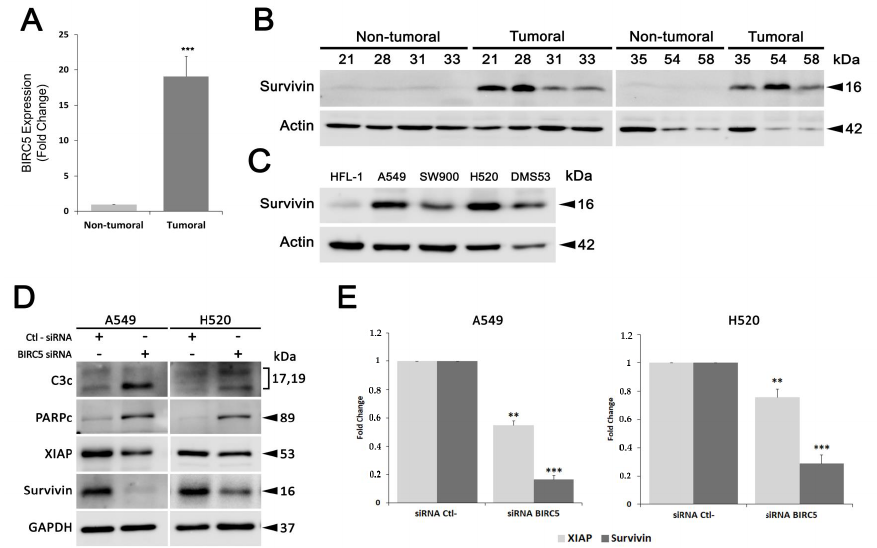
Figure 1. Survivin expression levels in lung cancer tumor samples and survivin functional validation in cellular models. ( A ) qPCR validation of BIRC5 expression levels. Fold changes of gene expression were calculated using β -actin as the housekeeping gene. ( B , C ), survivin levels were analyzed using whole cell lysates from patient tissue samples and lung cell lines by Western blot analysis. ( D , E ), After 48 h of transfection with siRNA against survivin mRNA, the expression of survivin, XIAP and pro-apoptotic proteins was analyzed by Western blot analysis in A549 and H520 cell lines. Protein levels were normalized with their respective loading controls in each blot. Results were obtained from at least three independent experiments. Bars represent the mean ± SD. Statistically significant results are indicated as *, p -value < 0.05; **, p -value < 0.01 and ***, p -value < 0.001. C3c, cleaved caspase 3; PARPc, cleaved